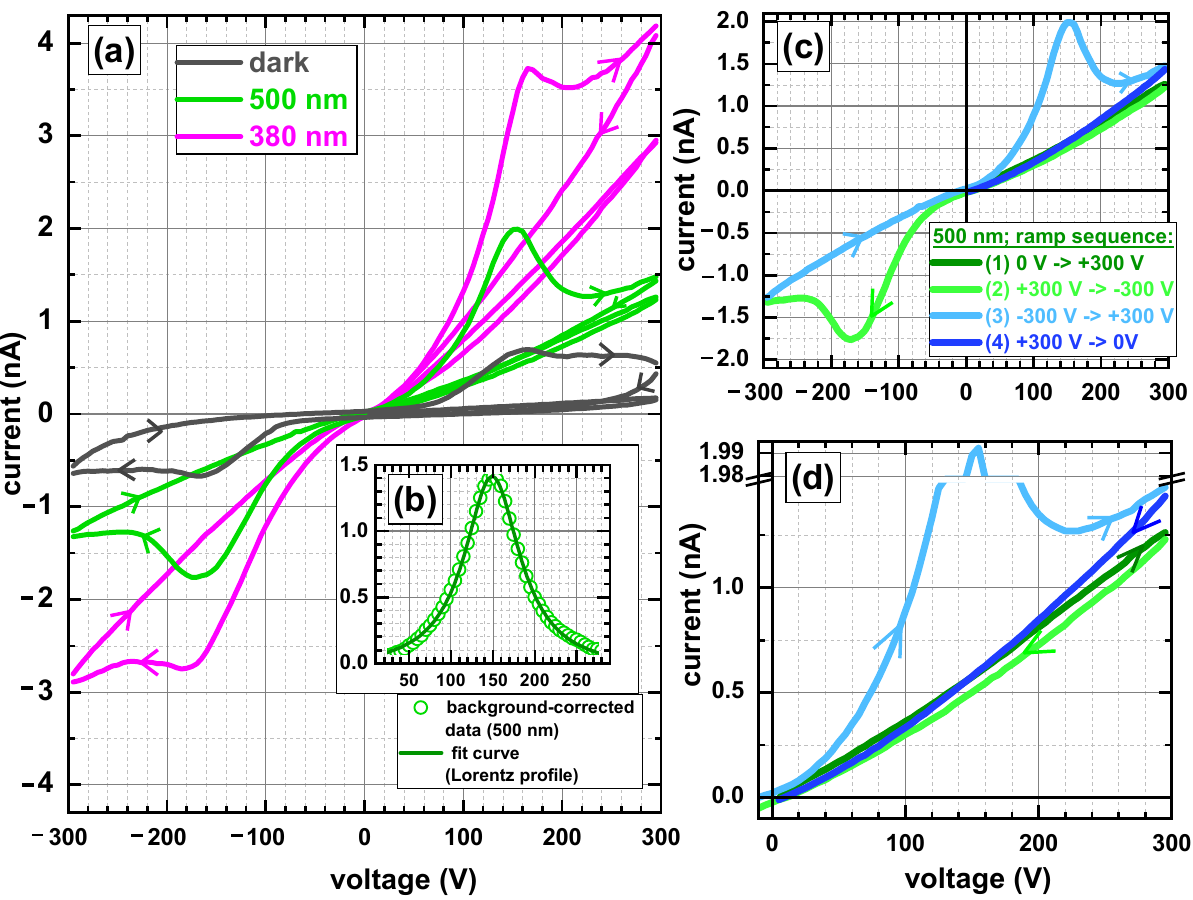
Figure 9. ( a ) Comparison of the current–voltage characteristics of the SBN61 crystal measured along the polar z-axis between ± 300 V in the dark (grey) and at 500 nm (green) as well as 380 nm (magenta) illumination, the latter two with a photon flux of 6.8 × 10 15 s − 1 . ( b ) Extraction of the coercive voltage by background correction and peak fitting for the positive-branch switching peak with 500 nm illumination. ( c ) Zoomed view of the IV-characteristics under 500 nm illumination with the different colors symbolizing the order of the applied voltage ramps. ( d ) As the close-up view of the first quadrant of subfigure ( c ) shows, there is no ferroelectric switching upon the initial ramp (dark green), since the ramp direction is parallel to the initial polarization direction in this